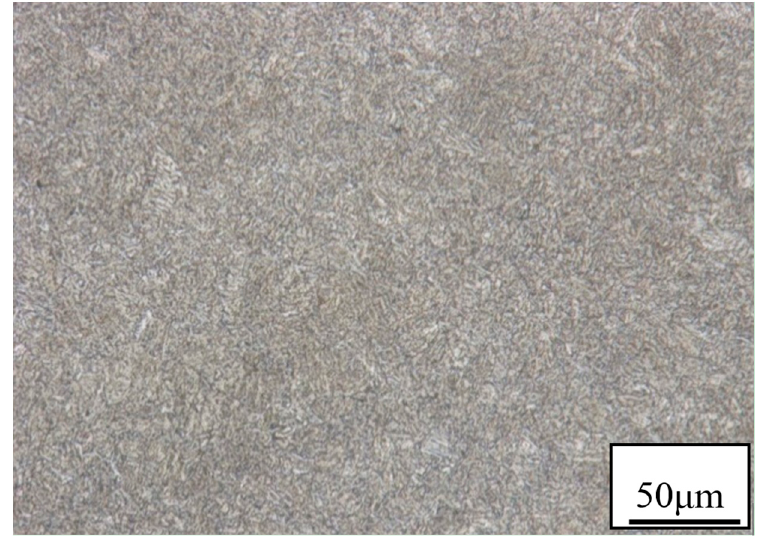
Figure 1. Microstructure of L80 steel.